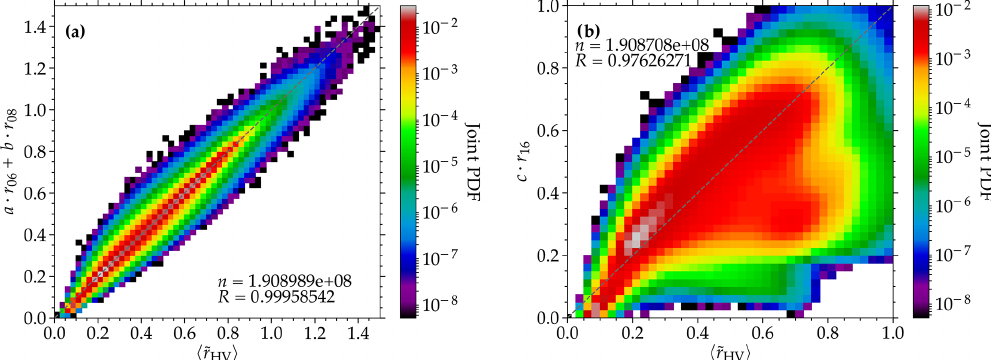
Figure 3. (a) Joint probability density function (PDF) of smoothed SEVIRI HRV reflectances ( (cid:104)˜ r HV (cid:105) ) and those obtained from a linear model of observed SEVIRI channel 1 ( r 06 ) and channel 2 ( r 08 ) reflectances, specifically a · r 06 + b · r 08 (see Sect. 4.1). Data are from all 5min SEVIRI observations of the Germany domain during June 2013. Only cloudy pixels are considered. The number of samples ( n ) and correlation coefficient ( R ) are given. (b) Same as (a) but for a linear model for SEVIRI SWIR reflectances, specifically c · r 16